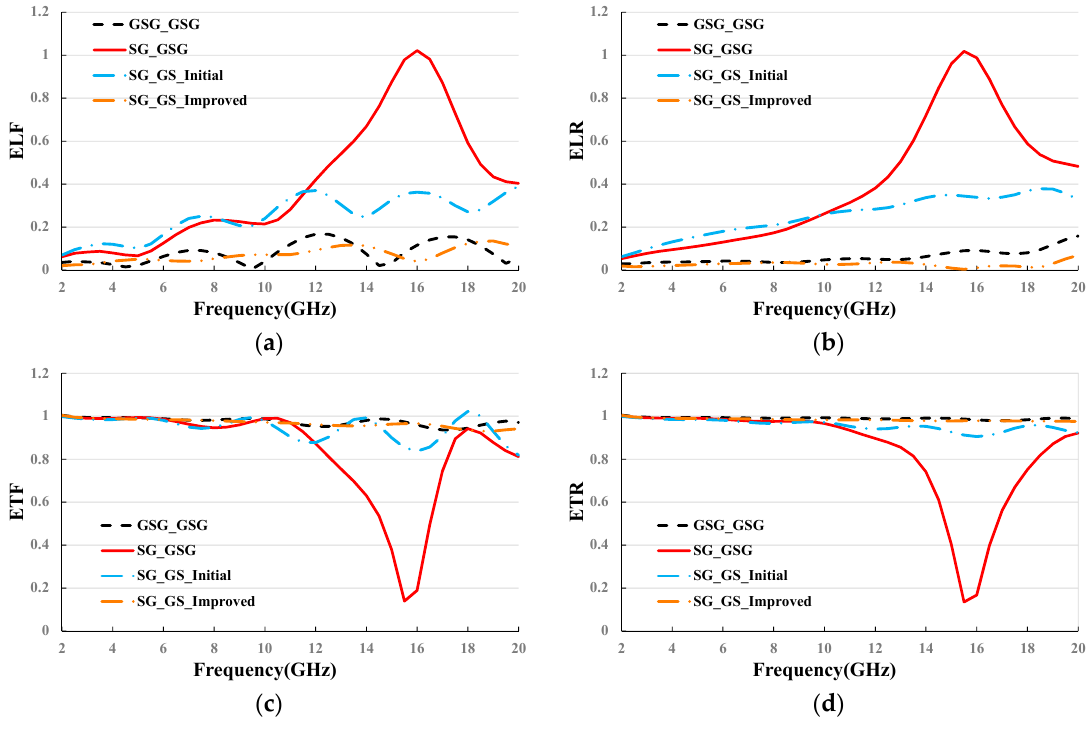
Figure 6. Comparison of error terms of SOLR calibration, with ( a – d ) corresponding to ELF, ELR, ETF and ETR respectively.